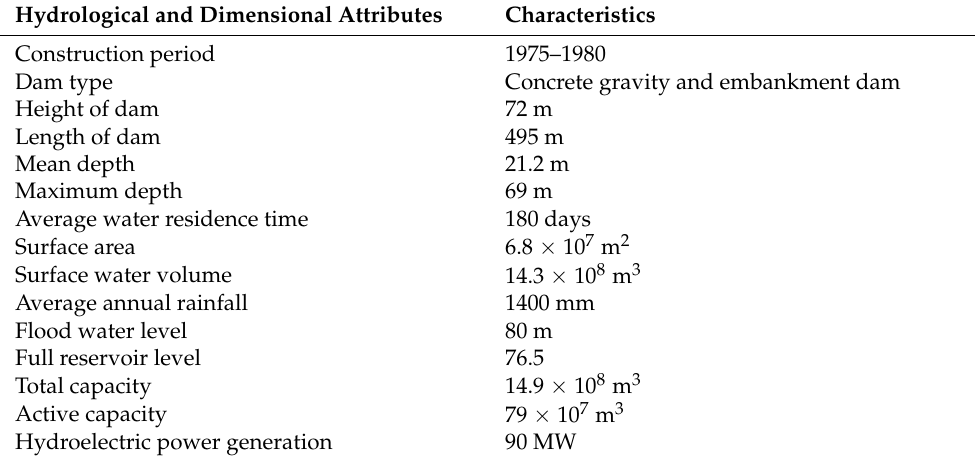
Table 1. Physical dimensions and hydrological characteristics of Daecheong Reservoir. Hydrological and Dimensional Attributes